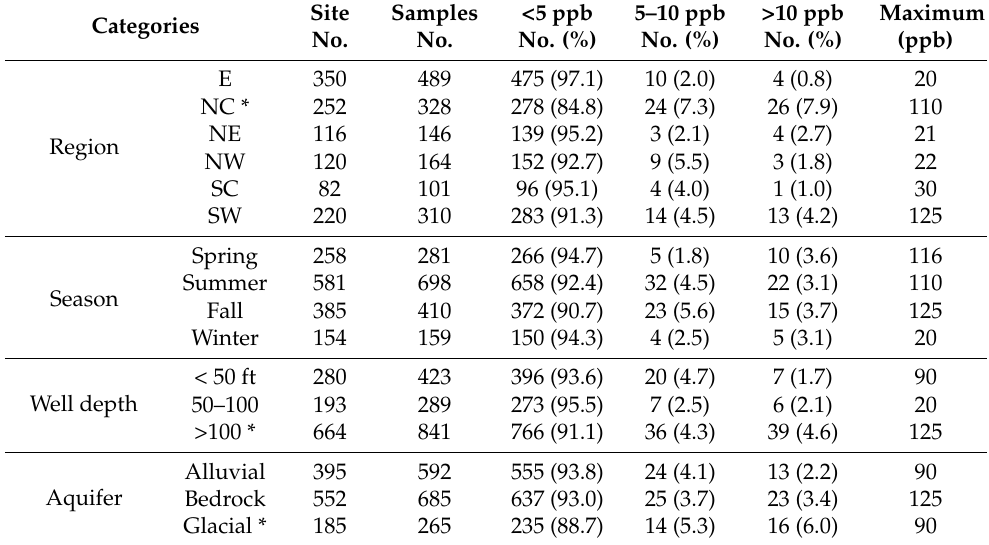
Table 2. Occurrence of Arsenic in Public Wells (Drinking Water MCL = 10